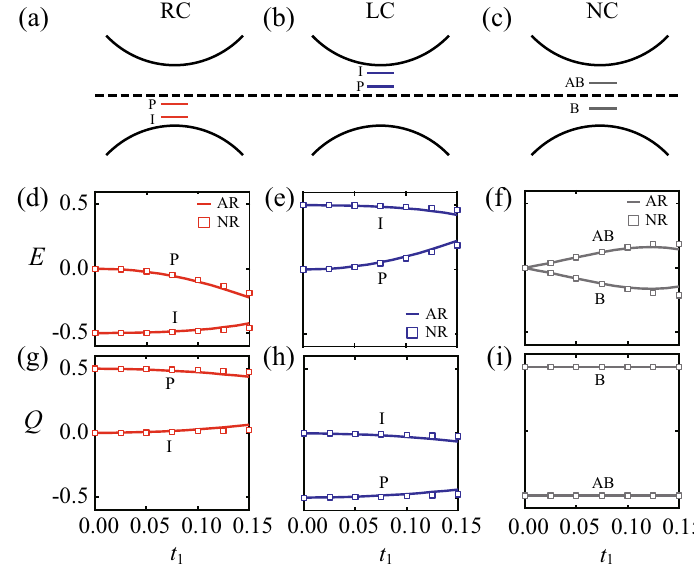
Figure 4. Schematics for the soliton modes of ( a ) RC, ( b ) LC, and ( c ) NC soliton systems. Energy spectra for soliton modes for ( d ) RC, ( e ) LC, and ( f ) NC systems with respect to t 1 . The spectra are normalized by the energy gap for each t 1 . The fermion numbers for soliton modes with respect to t 1 for ( g ) RC, ( h ) LC, and ( i ) NC systems. P, I, AB, and B represent the primary, induced, antibonding, and bonding modes, respectively. Analytical results (AR; lines) and numerical results (NR; squares) are calculated at the critical point t 1 = t 2